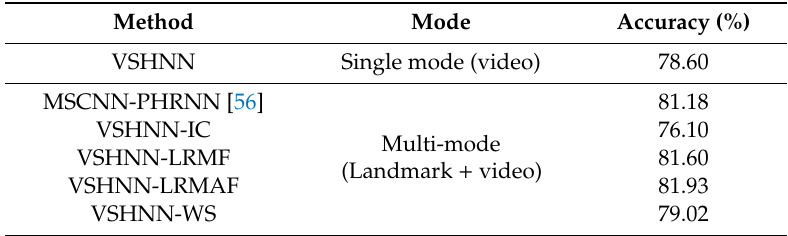
Table 13. Performance evaluation of multi-modal fusion for MMI